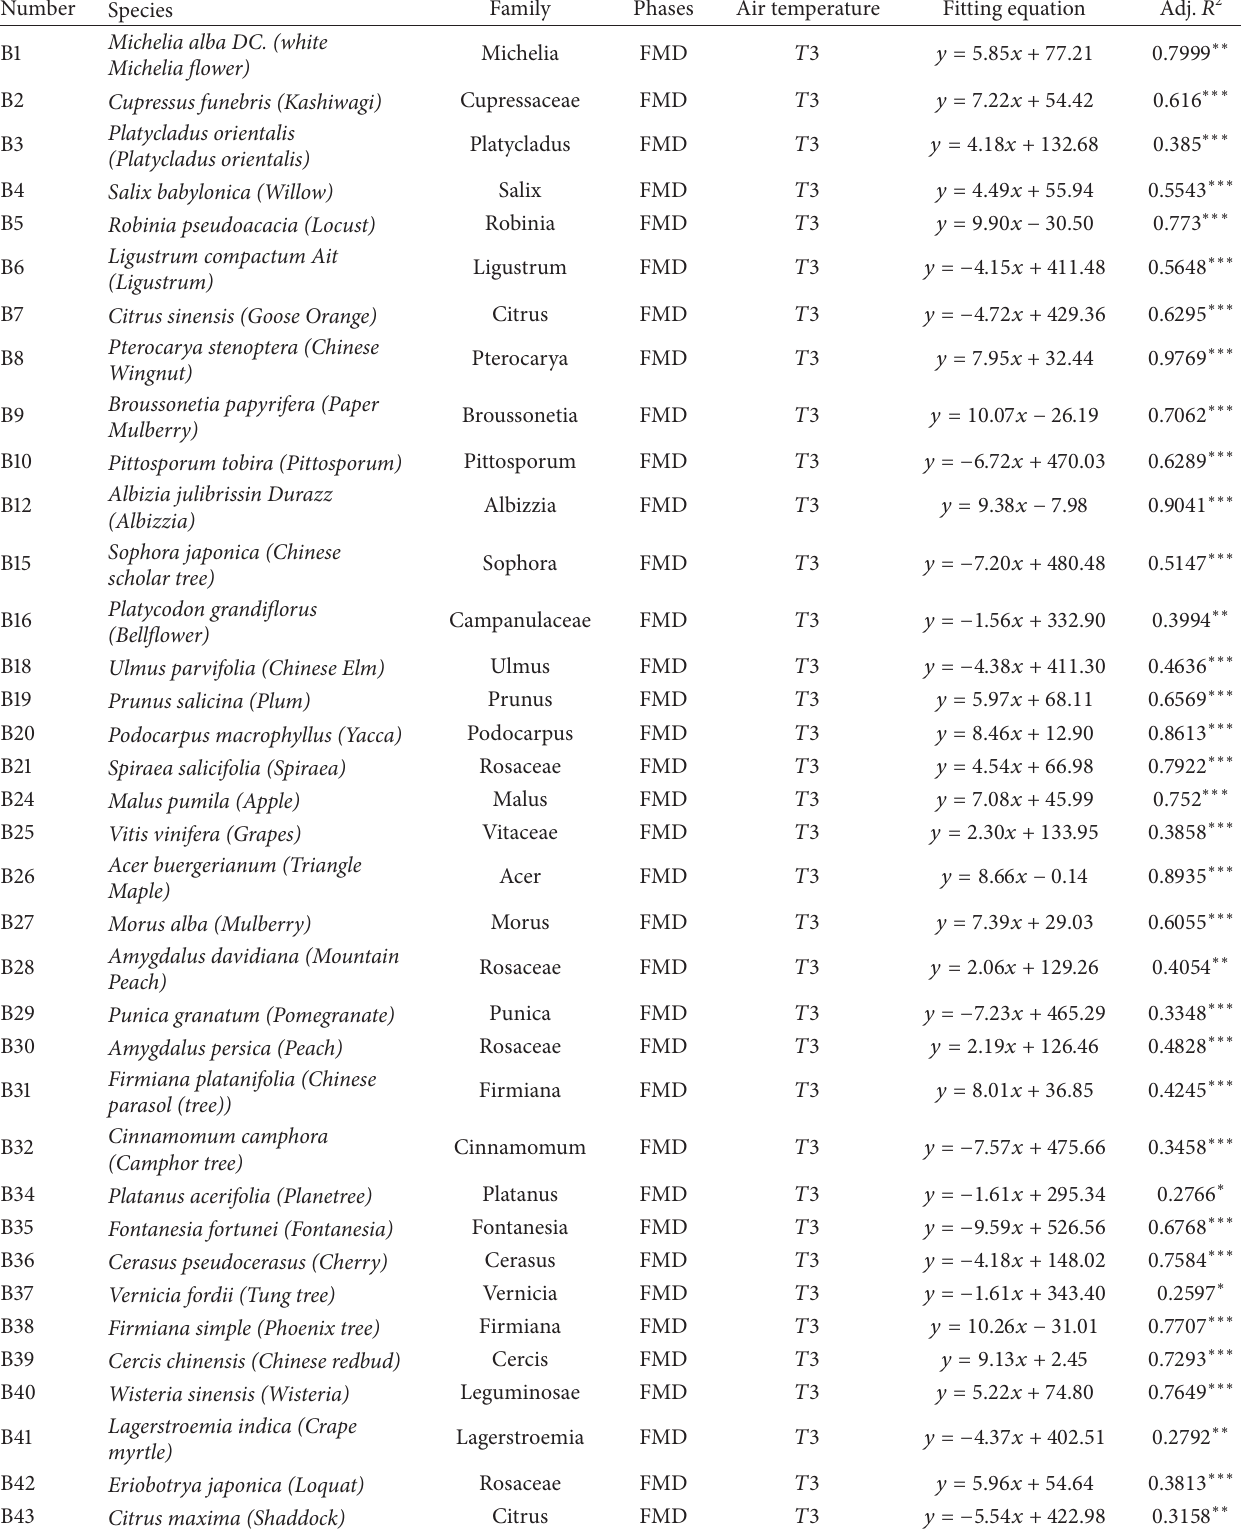
Table 3: Fitting equation of fruit maturity date and air temperature ( 𝑇3 ) in